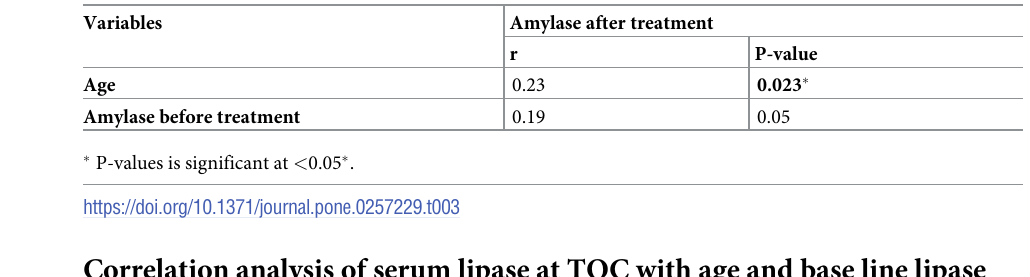
There was statistically significant positive correlation between serum lipase at TOC with age (r = 0.2022 and p-value = 0.0429 � ) and with base line serum lipase (r = 0.24 and p- value = 0.01). Pearson correlation between serum lipase at TOC with age and base line lipase (as shown in Table 5).